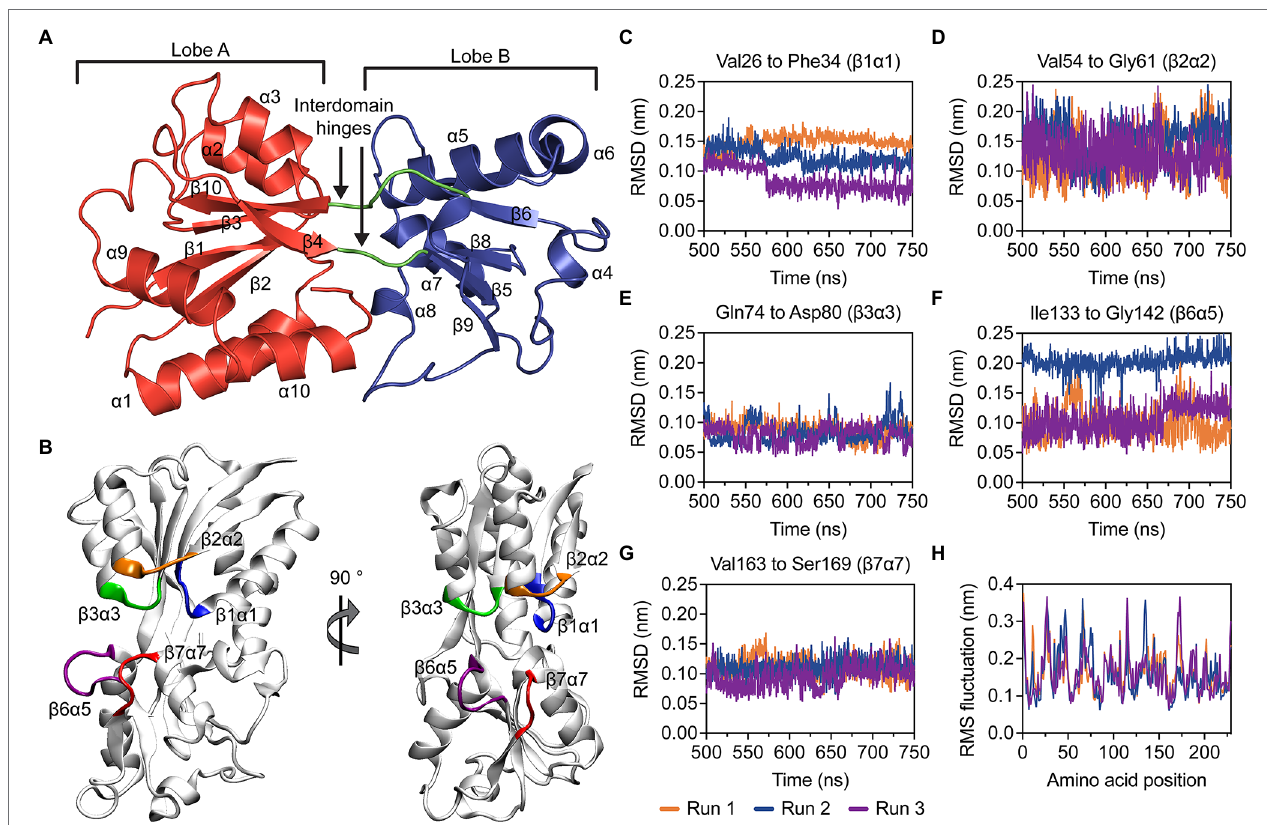
FIGURE 2 | Structural and molecular dynamics simulations analyses of metal-free P. aeruginosa ModA. (A) Cartoon representation of metal-free P. aeruginosa PAO1 ModA. Lobe A, lobe B and the interdomain hinges are shown in red, blue, and green, respectively. The secondary structures of the protein are assigned and labelled. (B) Dominant conformations of the metal-free ModA protein, determined by clustering analysis. Flexibility of the loops β 1 α 1 (blue), β 2 α 2 (orange), β 3 α 3 (green), β 6 α 5 (purple), and β 7 α 7 (red) was analyzed by measuring rmsd over time (C–G) . (H) RMS fluctuations of the residues in ModA. Data was calculated in triplicate 750 ns simulations and the data for each simulation is